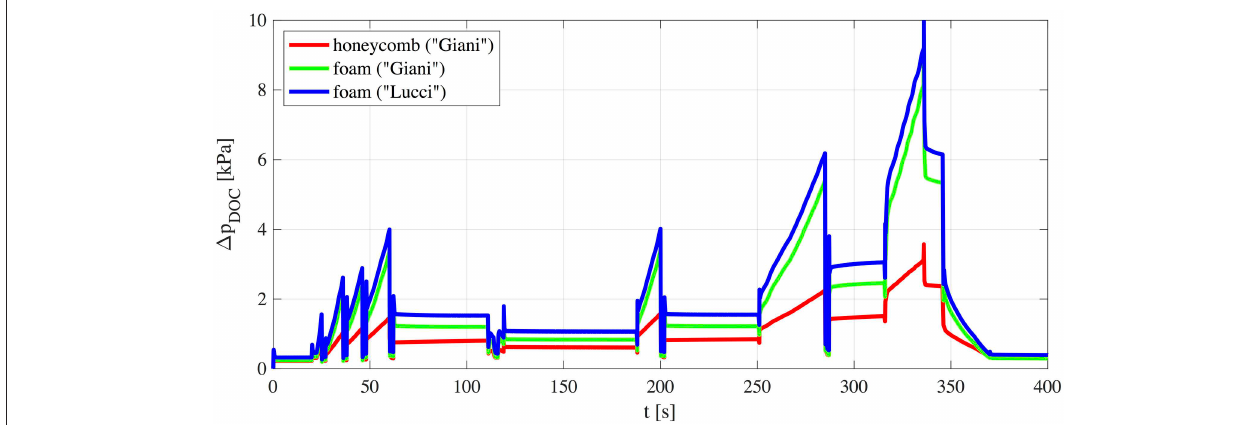
FIGURE 7 | Calculated pressure losses through different catalysts substrates.